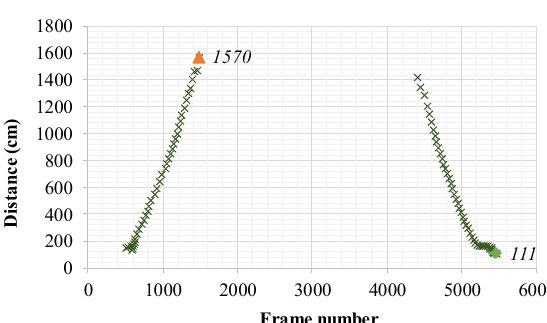
Figure 7. Maximum and minimum effective measurement distances